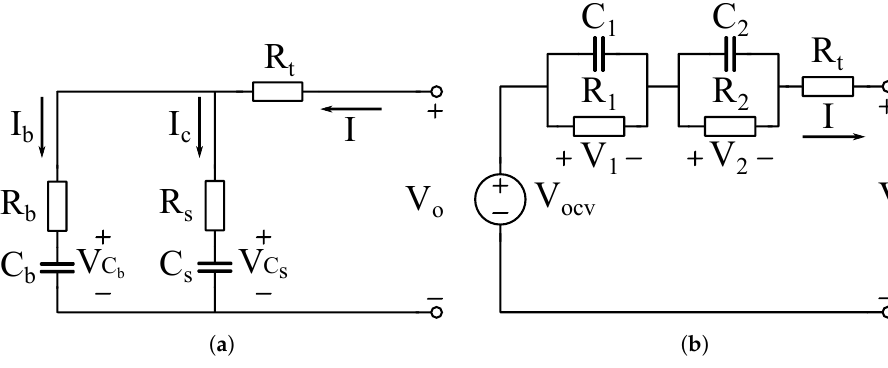
Figure 4. ( a ) RC Equivalent Circuit Model [30]. ( b ) Thevenin Equivalent Circuit Model